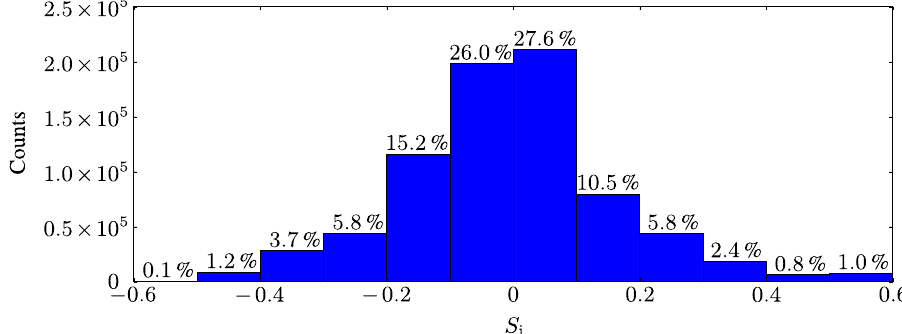
Fig. 6. Frequency distribution of the supersaturation ratio ( S i ) over the cloudy grid points and all model’s output times.